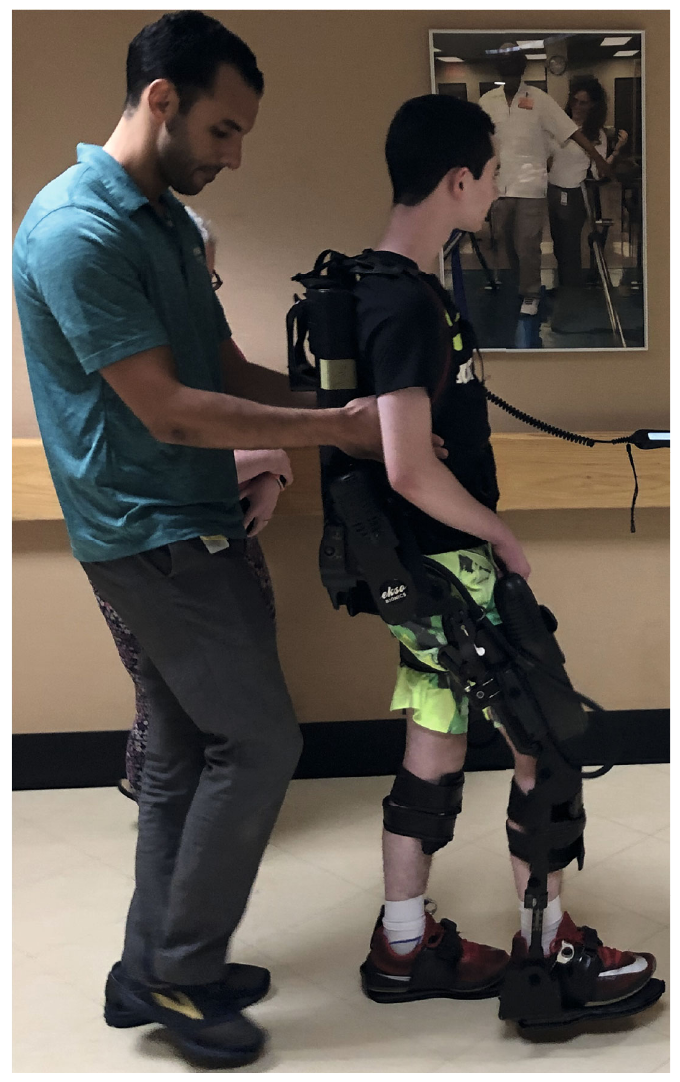
Figure 1: Robotic gait training with a participant with ABI administered by a trained physical